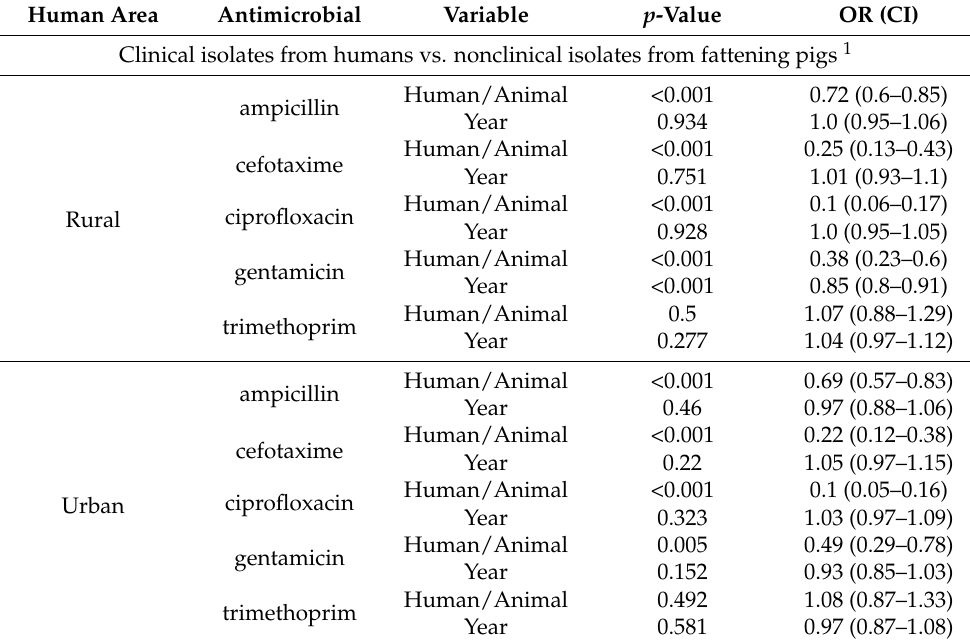
Table 3. Multivariable logistic regression analyses between human isolates from rural and urban areas and pig populations. Human Area Antimicrobial Variable Clinical isolates from humans vs. nonclinical isolates from fattening pigs 1